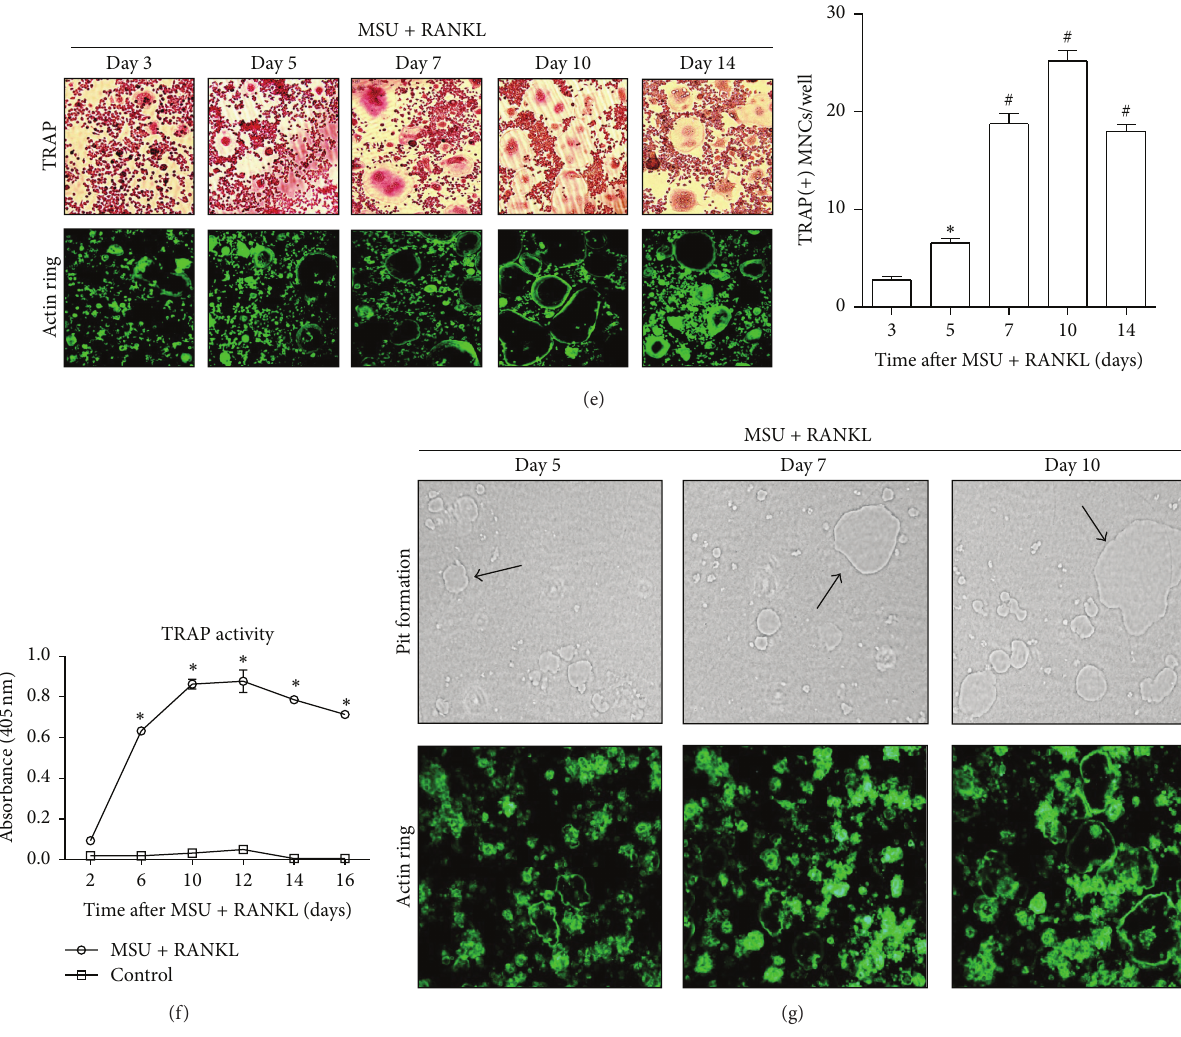
Figure 1: Osteoclast formation induced by stimulation with MSU crystals in the presence of RANKL. (a) RAW 264.7 cells alone (controls) were incubated with MSU crystals alone (0.1mg/mL), RANKL alone (100ng/mL), or both for 24 h. ∗ 𝑝 < 0.05 , # 𝑝 < 0.01 , and † 𝑝 < 0.01 . (b) TRAP staining and actin ring staining were performed in cells incubated with MSU crystals alone (0.1mg/mL), RANKL alone (100ng/mL), or both for 10 days. ∗ 𝑝 < 0.01 and # 𝑝 < 0.05 . (c) Production of TRAP protein was measured using the TRAP activity assay. RAW 264.7 cells alone (controls) were incubated with MSU crystals alone (0.1 mg/mL), RANKL alone (100ng/mL), or both for 24 h. ∗ 𝑝 < 0.05 , # 𝑝 < 0.01 , and † 𝑝 > 0.05 . (d) The mRNA expression of osteoclast-specific genes was measured. RAW 264.7 cells were treated with both MSU crystals (0.1mg/mL) and RANKL (100ng/mL) for 24h. ∗ 𝑝 < 0.05 and # 𝑝 < 0.01 . (e) TRAP and actin ring staining were performed after stimulation of RAW 264.7 cells with both MSU crystals (0.1mg/mL) and RANKL (100ng/mL). ∗ 𝑝 < 0.05 and # 𝑝 < 0.01 . (f) TRAP activity was measured and compared between RAW 264.7 cells incubated with both MSU crystals (0.1mg/mL) and RANKL (100ng/mL) and control cells. ∗ 𝑝 < 0.01 by ANOVA. (g) Functional assessment for activated osteoclasts was performed using the pit formation assay. The assay was performed at days 5, 7, and 10 after stimulation with both MSU crystals (0.1 mg/mL) and RANKL (100ng/mL). Arrows indicate pits formed by activated osteoclasts. The experimental data were determined by at least three independent